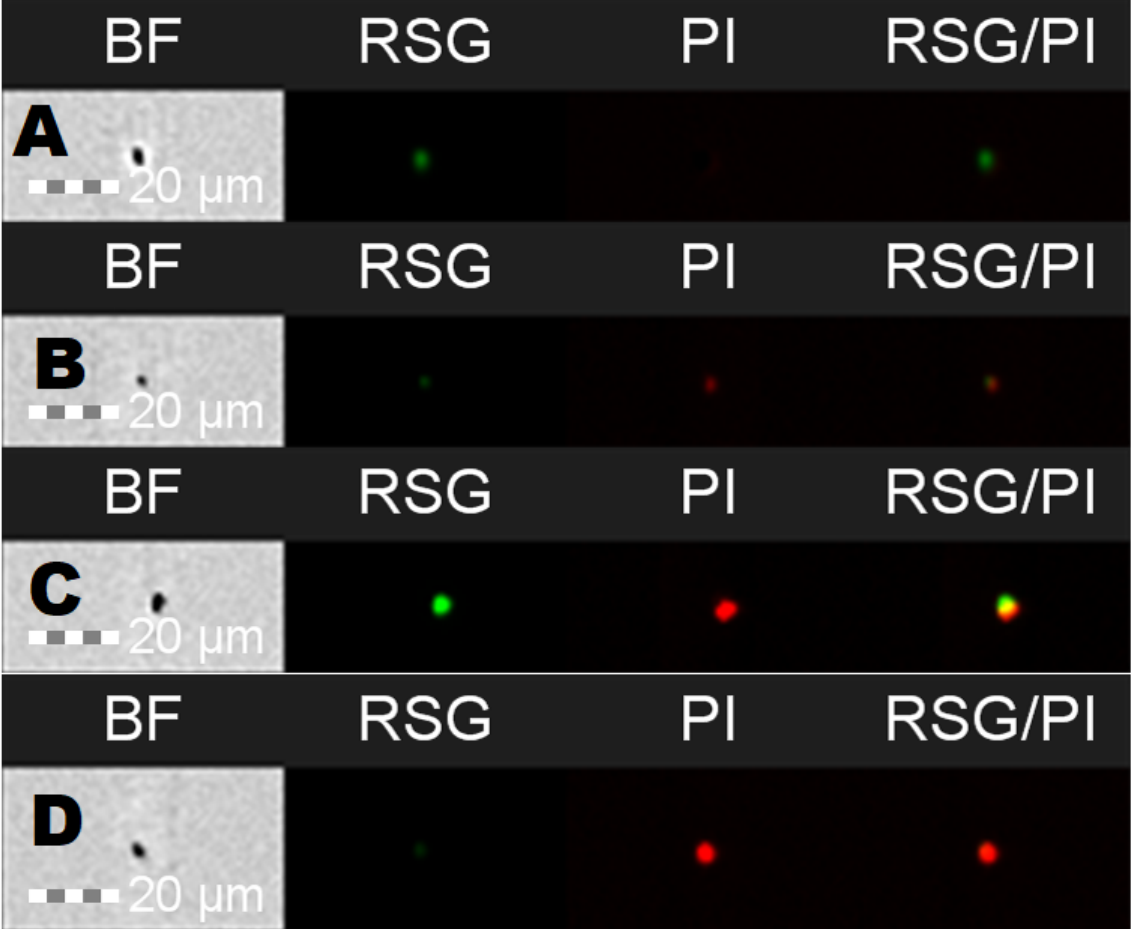
Figure 2. Flow cytometric images of cells for different channels: BF—brightfield, RSG—RedoxSensor TM Green, PI—propidium iodide, RSG/PI—mixed signals for both dyes. Samples represent different subpopulations: A—active, B—mid-active 1, C—mid-active 2, D—dead.